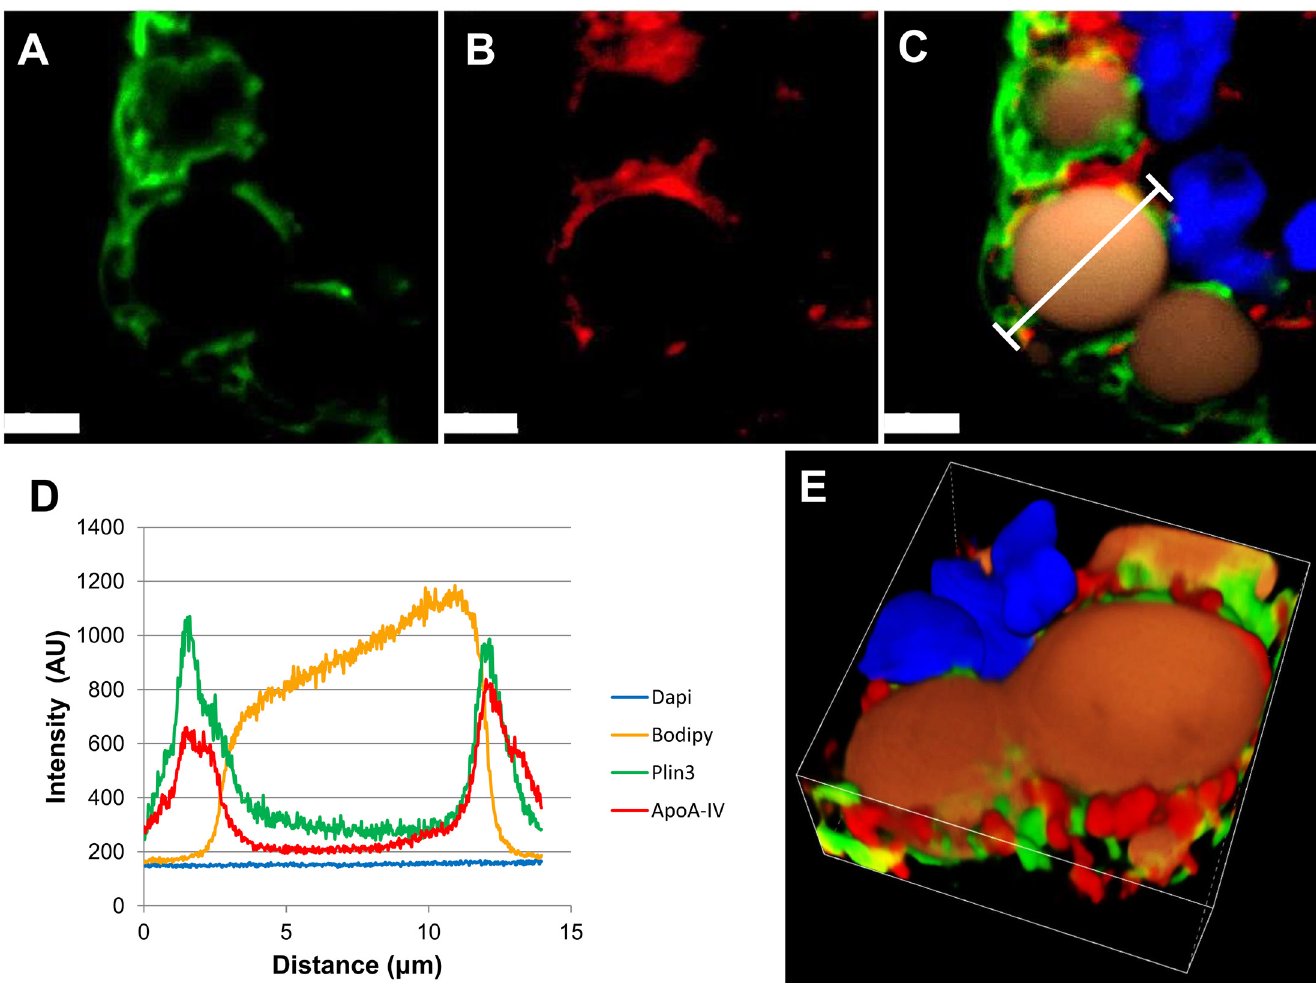
Fig 5. Immunofluorescence imaging of Plin3 and ApoA-IV demonstrates localization on or around CLDs. Representative confocal immunofluorescence images of enterocytes two hours after a 200 μ l olive oil bolus (n = 4 mice). Frozen sections were immunostained for Plin3 in green (A) and ApoA-IV in red (B). Lipids were stained with Bodipy (orange) and nuclei stained with Dapi (blue) and the signals were merged. Bars = 5 μ m(C). The signals from Plin3 and ApoA-IV have a Pearson ’ s correlation of 0.59 and a Mander ’ s overlap of 0.96 indicating a high degree of colocalization. A capped white line denotes a region of interest and the intensity profile along the line of the signals was generated (D) and indicates the signals of Plin3 and ApoA-IV overlap and flank the CLD. A 3D volume view was generated from Z-series images (E) with the dimensions of 15.91 x 15.91 x 7.5 μ m was generated and indicates Plin3 and ApoA-IV localizes to the area on or around the